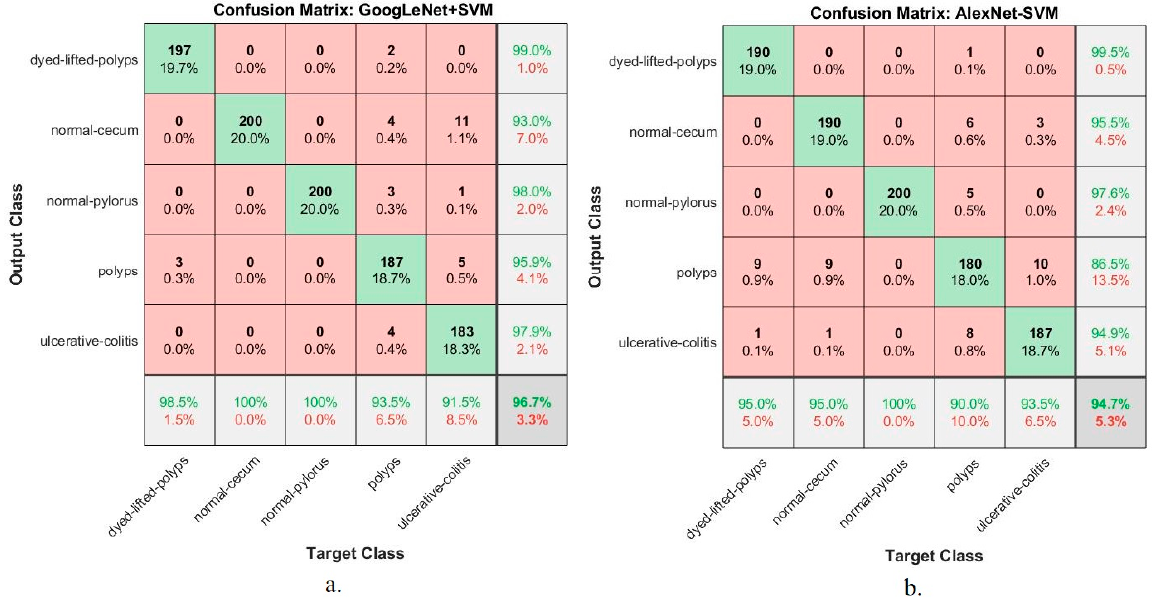
Figure 21. Confusion matrix for evaluating of lower GI dataset using ( a ) GoogLeNet+SVM and ( b ) AlexNet+SVM.